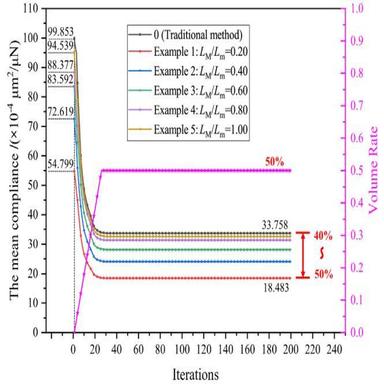
Optimization iteration history for the cantilever beam with different Lm.